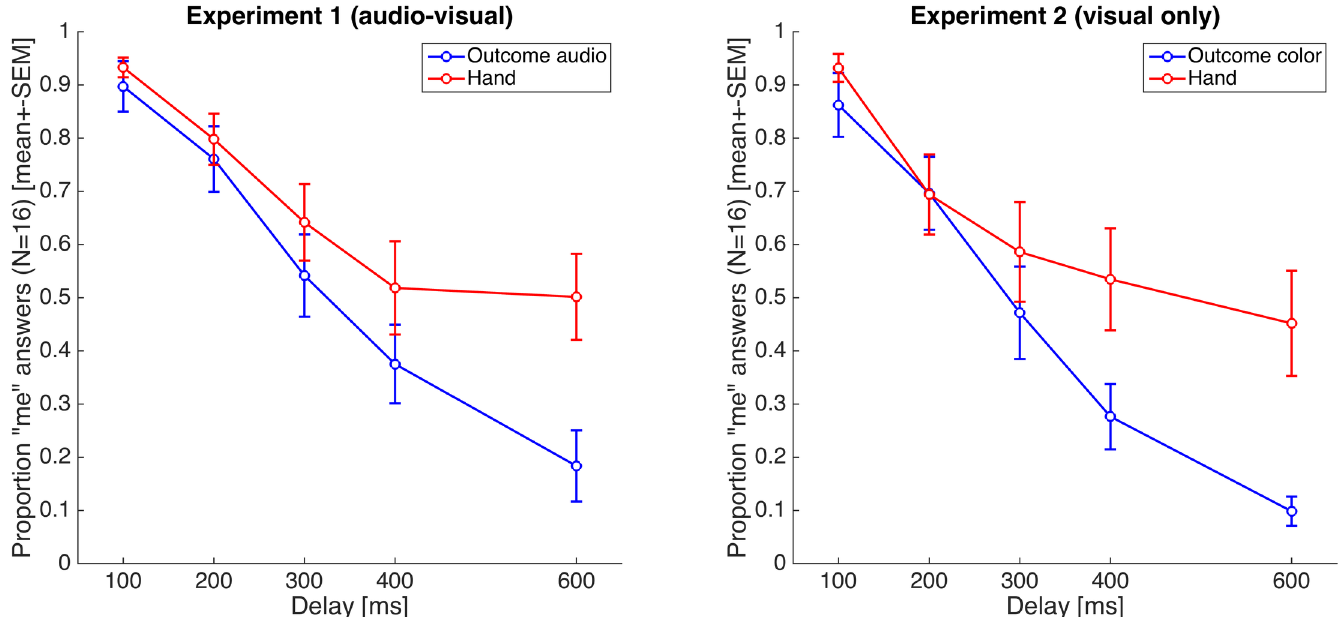
Fig 2. Sense of agency as a function of delay across conditions (i.e., feedback types) and experiments. Perceptual reports of self-agency (i.e., proportion ‘ me ’ ) are plotted as a function of delay (i.e., 0, 100, 200, 300, 400, 600 ms) of the visual feedback about the movement itself ( ‘ hand ’ condition) or the feedback about the movement outcome (Experiment 1: ‘ outcome audio ’ , Experiment 2: ‘ outcome color ’ condition). Data are mean values over all participant, error bars represent one standard error of the mean.